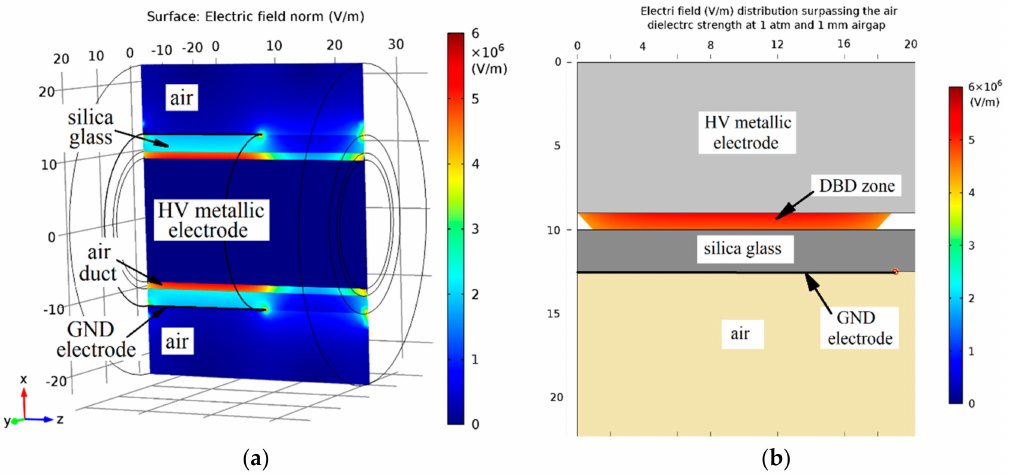
Figure 9. Electrostatic finite element method (FEM) simulation results for a simplified volume DBD OG model: ( a ) electric field distribution at 10 kV HV supply, ( b ) air gap breakdown section corresponding to Paschen air breakdown strength at 1 atm and 1 mm gap (spatial dimensions in